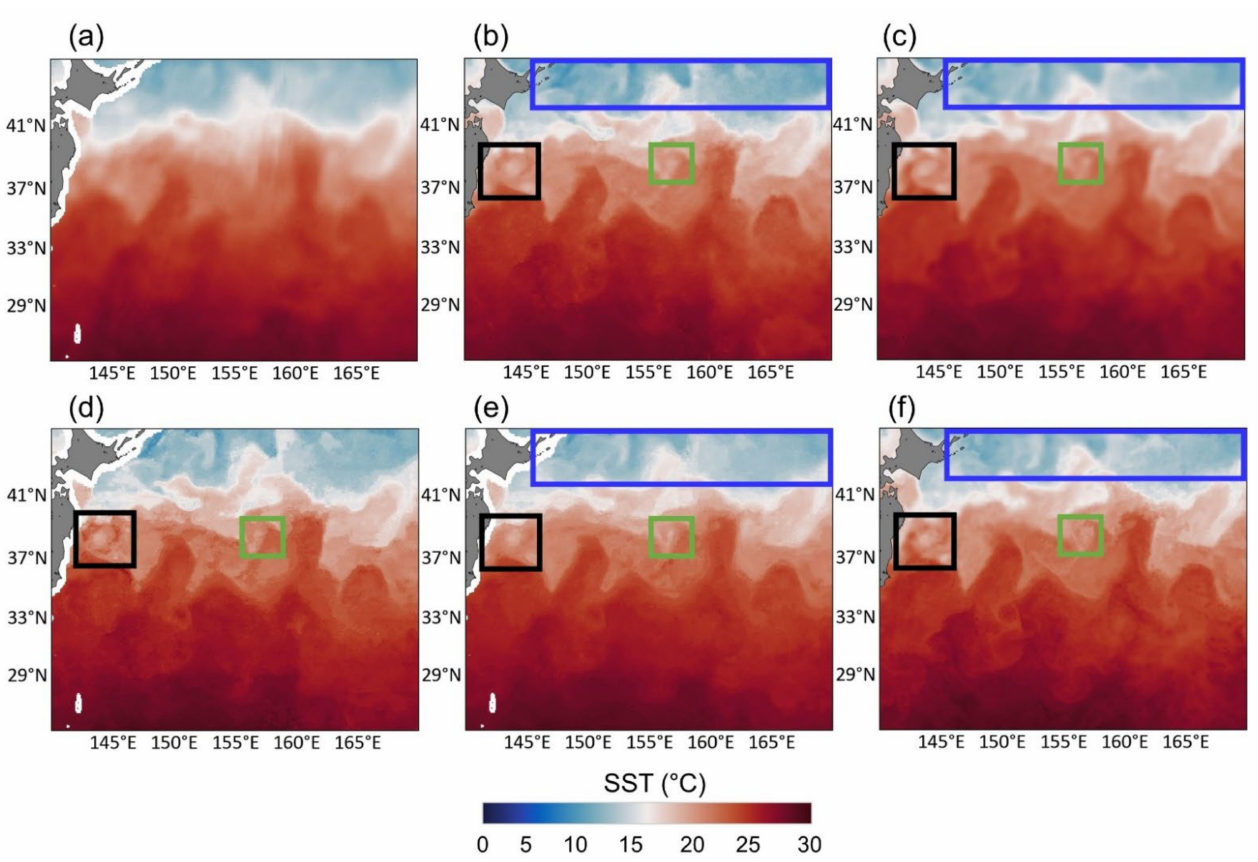
Figure 8. Spatial distribution of SSTs on 6 November 2018: ( a ) the reconstructed AMSR2 SST, ( b ) the reconstructed MODIS SST, ( c ) OSTIA SST, ( d ) scheme 1-based SST, ( e ) scheme 2-based SST, and ( f ) multiscale ultra-high-resolution (MUR) SST. The spatial resolutions of the SST data are 10, 4, 4, and 4 km and 0.05 ◦ and 0.01 ◦ ,